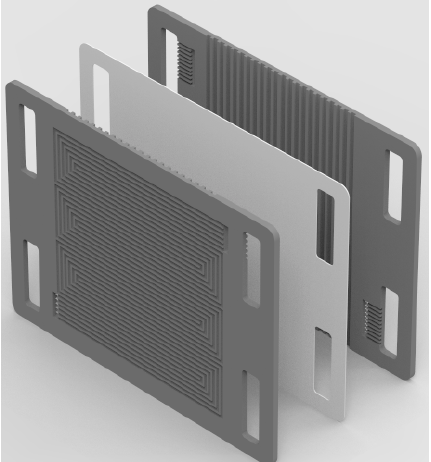
Figure 5. Exploded view of a bipolar plate. Internal flow fields deal with air cooling and external flow fields with reactant distribution/product collection.